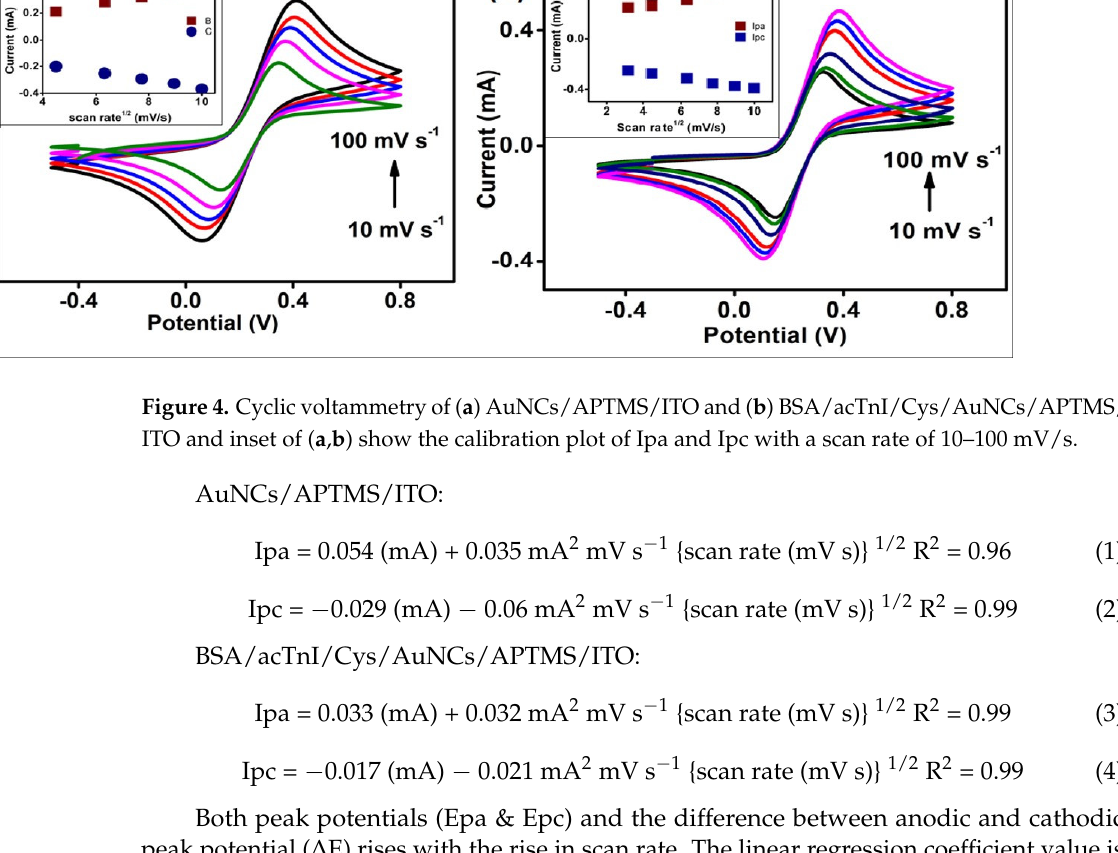
Figure 3. (a) Bare ITO (b) Au bilayer (c) AuNCs/APTMS/ITO (d) Cys/AuNCs/APTMS/ITO (e) acTnI/Cys/AuNCs/APTMS/ITO (f) BSA/acTnI/Cys/AuNCs/APTMS/ITO at a scan rate of 100 mV/S within a potential −0.4 V to 0.8 V in PBS buffer containing [Fe(CN) 6 ] 3− /4− . The cyclic voltammetry of AuNCs/APTMS/ITO and the BSA/acTnI/Cys/AuNCs/APTMS/ITO immunoelectrode (Figure 4) was studied with a 10– 100 mV s −1 scan rate. Since the value of both cathodic (Ipc) and anodic (Ipa) peak currents rises progressively with the square root of the scan rate, there is more possibility for a diffusion-controlled process. The slopes and intercepts for AuNCs/APTMS/ITO and BSA/acTnI/Cys/AuNCs/APTMS/ITO are given by the following equations.